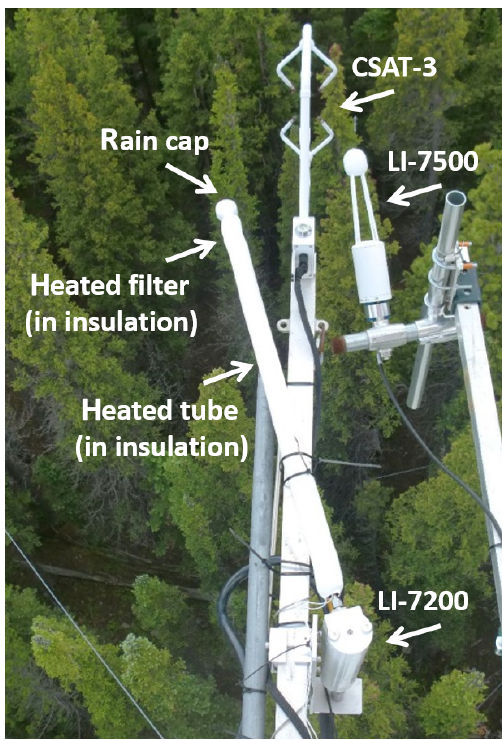
Figure 2. Field test setup at the Niwot Ridge US-NR1 Ameri- Flux site. A LI-7200 enclosed-path IRGA and a LI-7500 open-path IRGA are operated side by side next to a CSAT3 sonic anemome- ter. The LI-7200 gas sampling system consists of rain cap, filter and tube, as well as insulation and adjustable heating of the filter and